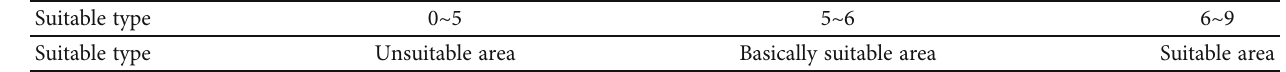
Table 7: Suitability classi fi cation index of the buried pipe ground source heat